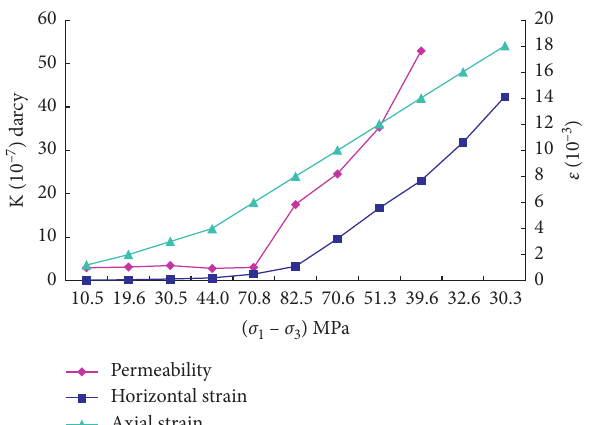
Figure 8: Permeability-horizontal strain-axial strain curves of A2-2.